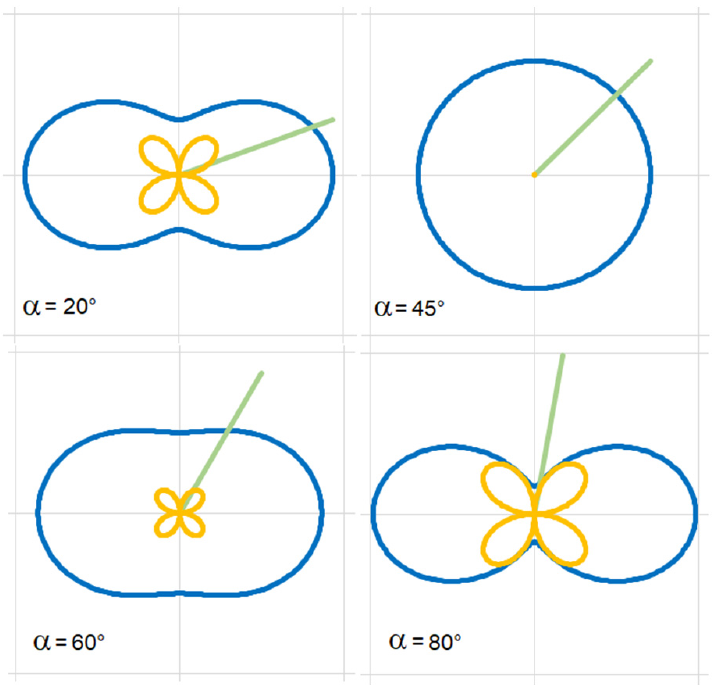
Figure 4. Symmetric tensor glyphs: 𝛼 = 20°, 45°, 60°, and 80° . As shown, symmetric tensor glyphs repeat their shapes with changes in the initial angle. Different shapes are limited to a single